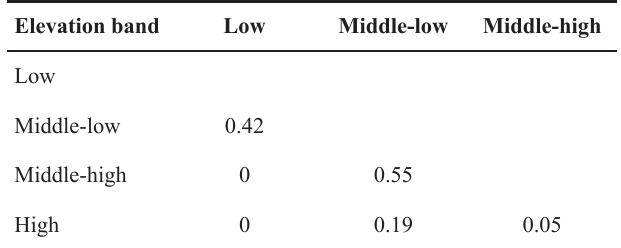
Table 2 – Paired complementarity matrix of the Morisita index between the elevational belts along the study transect, based on species frequencies. 1 indicates identical assemblages and 0 total dissimilarity (Chao et al.